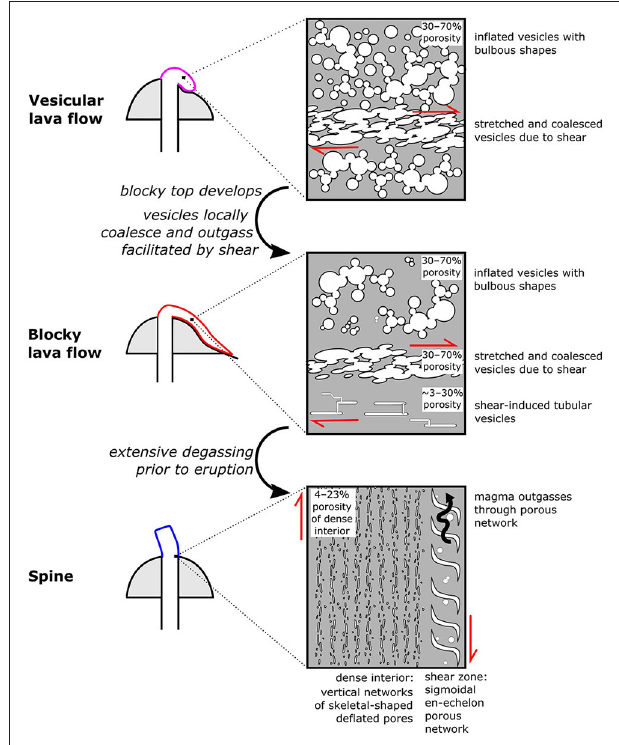
FIGURE 9 | Conceptual model of pore development at